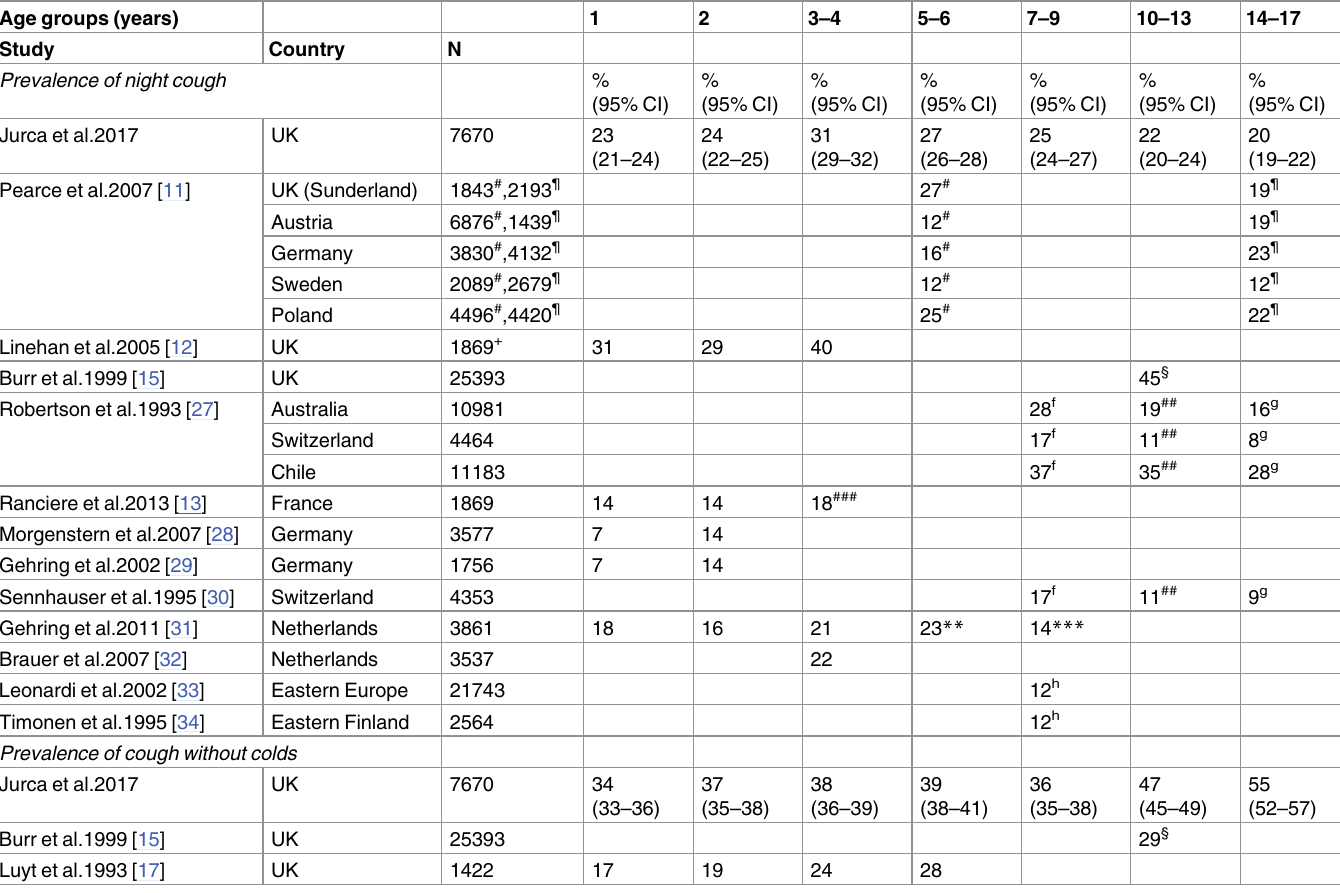
Table 4. International comparison of age-specific prevalenceof cough, assessedby different